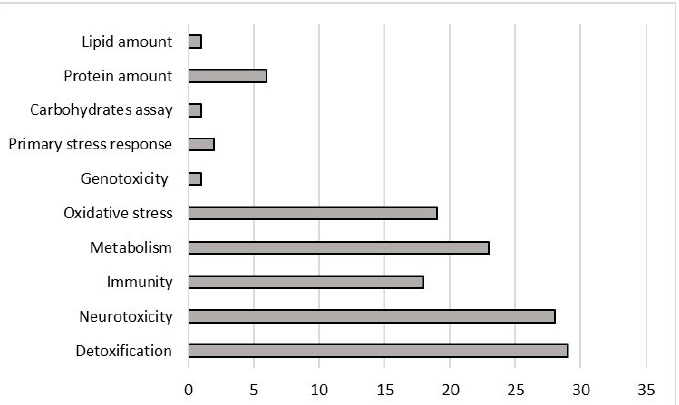
Figure 6. Number of studies, divided by molecular and enzymatic responses, on Apis mellifera , that met the criteria for inclusion in this review.